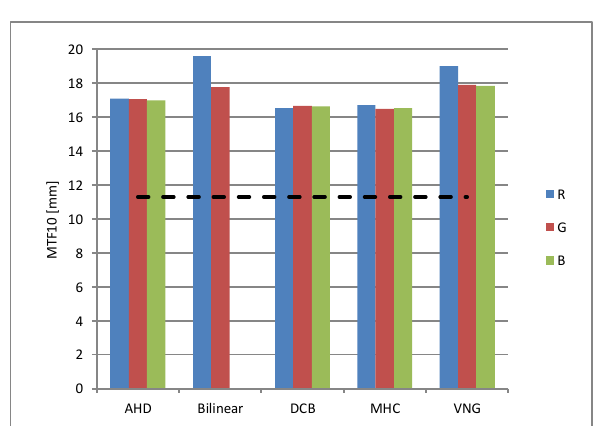
Figure 11: Determined image resolution (kinematic) per demosaicing method and channel (native GSD of 11mm – dashed